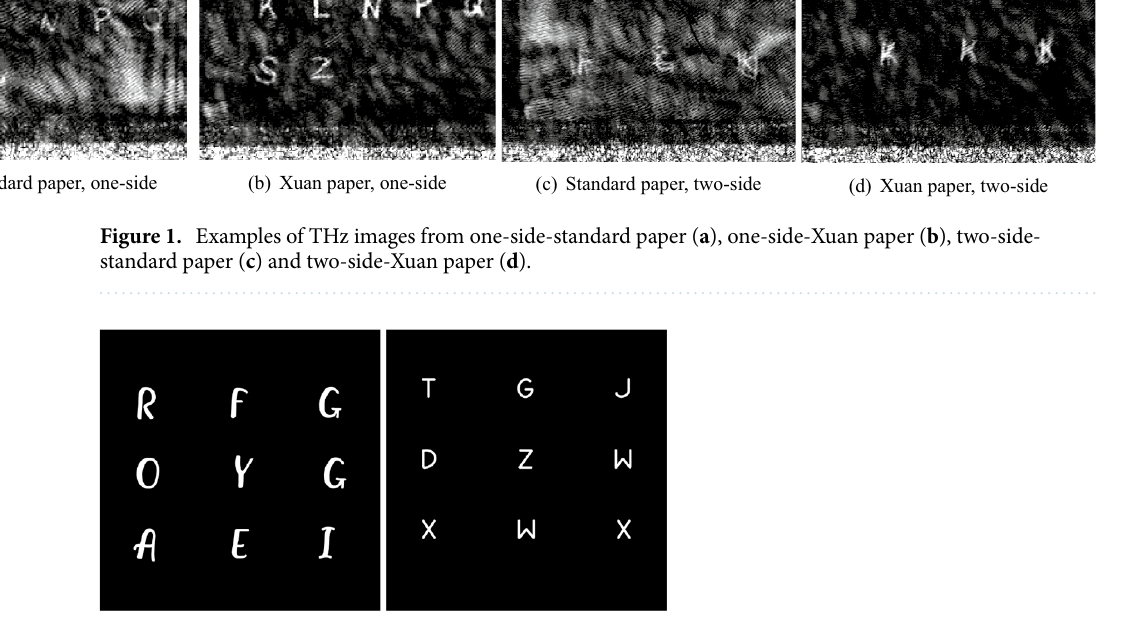
Figure 2. Two exemplary images generated by the handwriting generator with two different